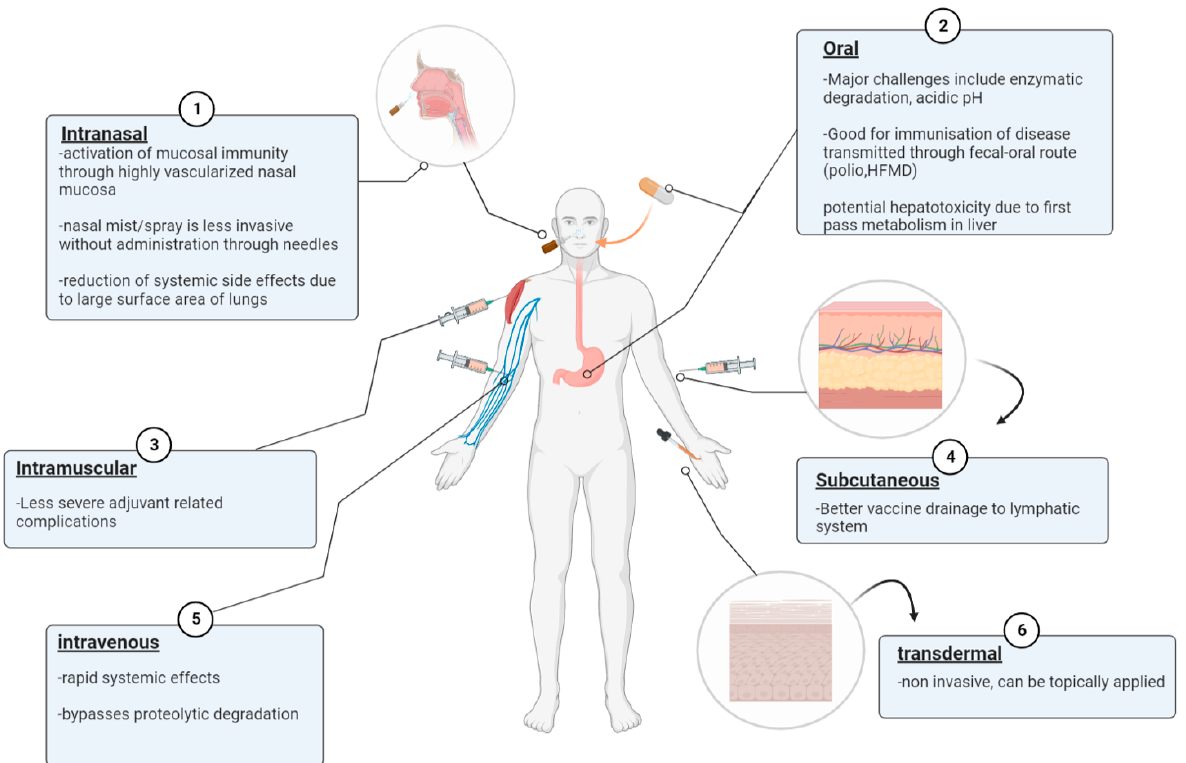
Figure 1. Different vaccine administration routes against infectious diseases including intramuscular (IM), subcutaneous (SC), oral, intranasal, and intravenous (IV).